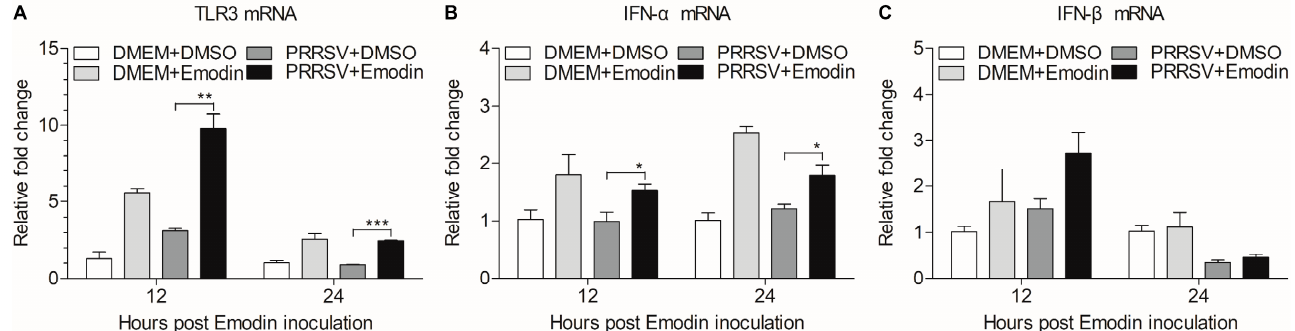
Figure 6. Emodin-induced activation of TLR3-mediated response after PRRSV infection. iPAMs were treated with Emodin (6.25 μ g/mL) for 1 h, followed infection with PRRSV at a MOI of 0.1. After 1 h, the cells were re-treated with Emodin. Without Emodin treatment and without PRRSV infection, Emodin treatment only and PRRSV infection only as controls. At 12 hpi and 24 hpi, the mRNA expression levels of TLR3 ( A ), IFN- α ( B ) and IFN- β ( C ) in iPAMs were examined by real-time PCR using specific primers. The mRNA expression levels of these molecules were normalized relative to the expression level of GAPDH . Data are represented as mean ± SD, n = 3. * p < 0.05, ** p < 0.01, *** p < 0.001.